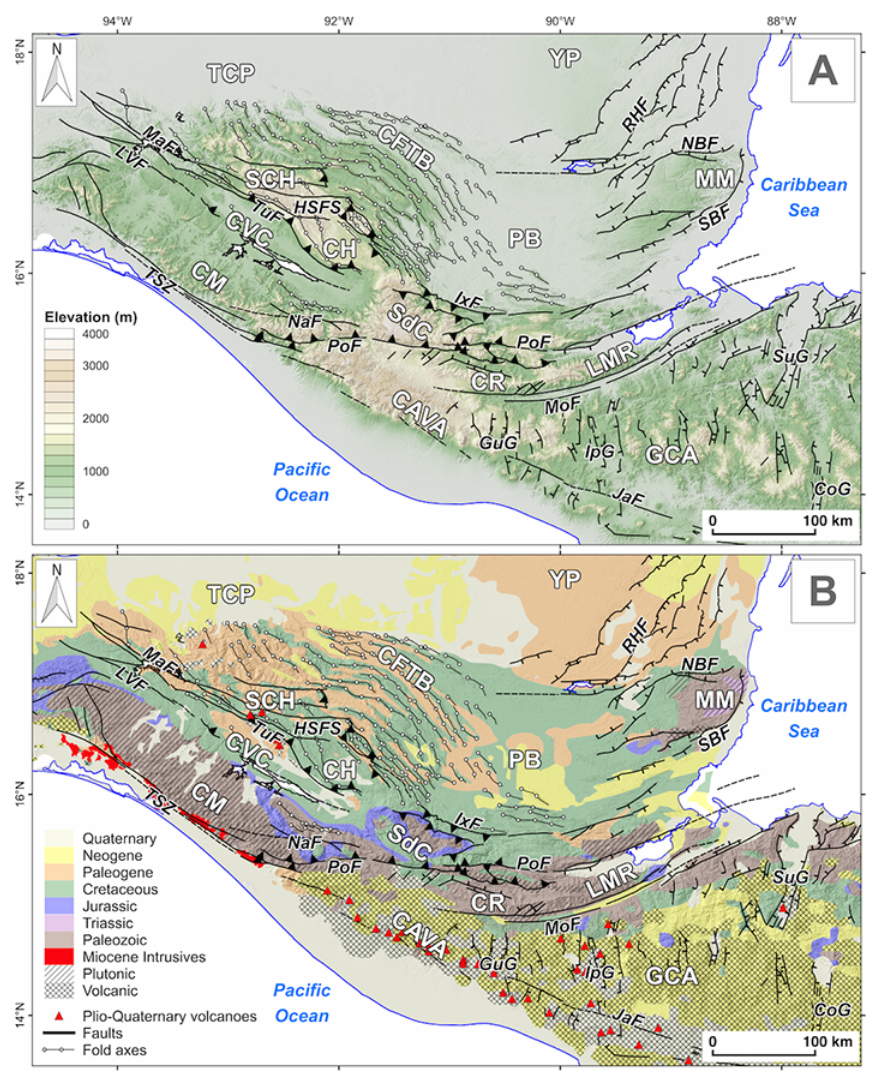
Figure 2. Topography (a) and simplified geological map (b) for northern Central America. Geological contours from Garrity and Soller (2009). Structures compiled from Guzmán-Speziale (2001), Meneses-Rocha (2001), Rogers et al. (2002), Purdy et al. (2003), Ratschbacher et al. (2009), Authemayou et al. (2011) and Witt et al. (2012b). Morpho-tectonic domains: CAVA – Central American volcanic arc;